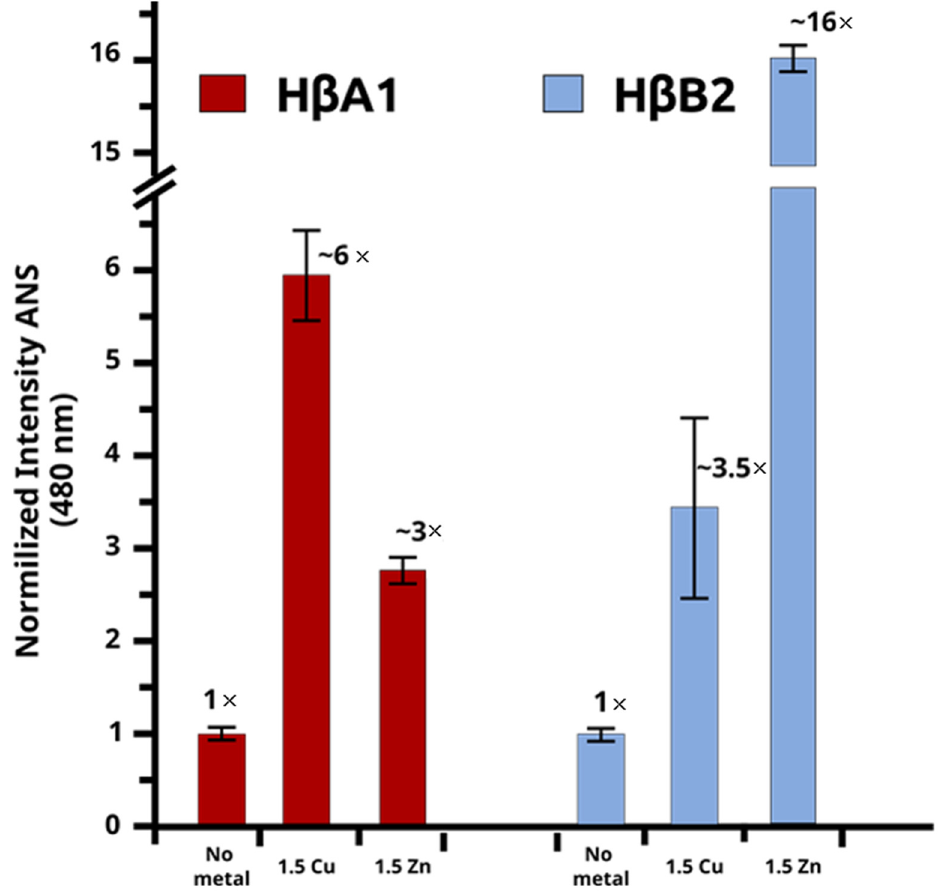
Figure 5. Normalized ANS fluorescence intensity. H β A1 (red) without the metals and with 1.5 eq of Cu(II) and Zn(II). H β B2 (blue) without the metals and with 1.5 eq of Cu(II) and Zn(II).